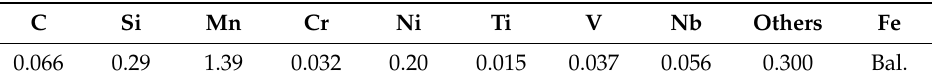
Table 1. Chemical composition of the X70 steel specimens (wt